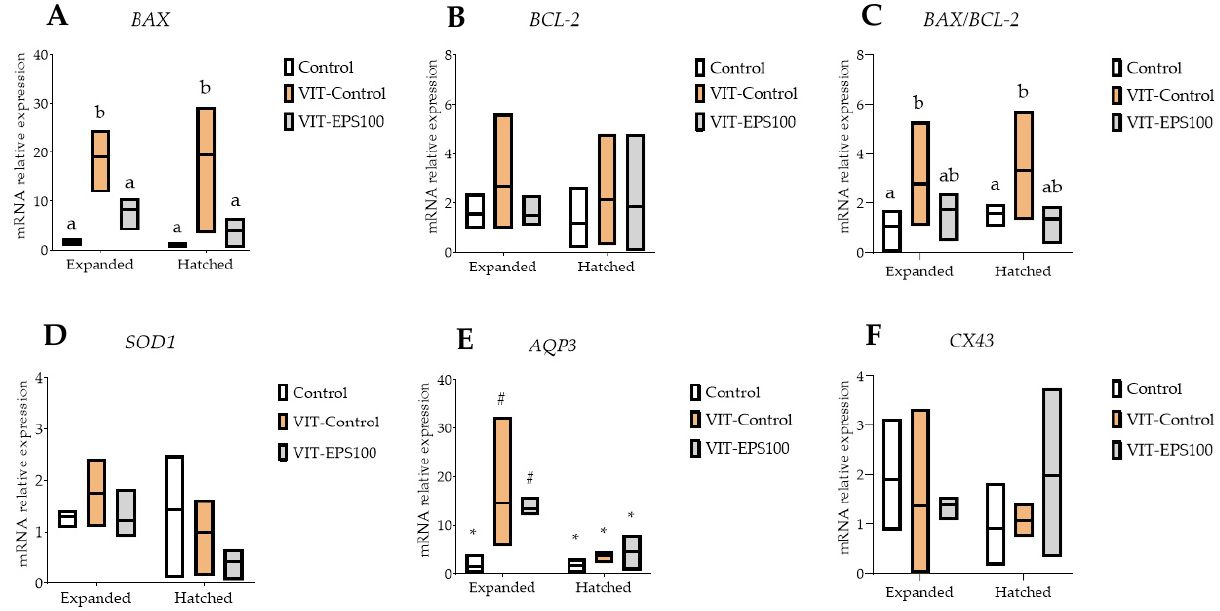
Figure 1. Box plots (solid line indicates the mean) showing expression levels of ( A ) BAX , ( B ) BCL-2 , ( C ) BAX/BCL-2 ratio, ( D ) SOD1 , ( E ) APQ3 , ( F ) CX43 in post-warmed expanded and hatched blastocysts developed from vitrified/warmed Day 7 expanded blastocysts derived from cow oocytes. Control: fresh non-vitrified expanded blastocysts; VIT-Control: blastocysts vitrified/warmed without EPS ID1 supplementation; VIT-EPS10: blastocysts vitrified/warmed with 10 µ g/mL EPS ID1 supplementation; VIT-EPS100: blastocysts vitrified/warmed with 100 µ g/mL EPS ID1 supplementation. a,b Different letters indicate significant differences between treatments ( p ≤ 0.05).* ,# Different symbols indicate differences between developmental stages inside each specific treatment ( p ≤ 0.05). BAX , BCL2-associated X apoptosis regulator; BCL-2 , BCL2 like 1; SOD1 , superoxide dismutase 1; AQP3 , aquaporin 3; CX43 , connexin 43; Expanded, expanded blastocysts; Hatched, hatching/hatched blas- tocysts. 3. Discussion.